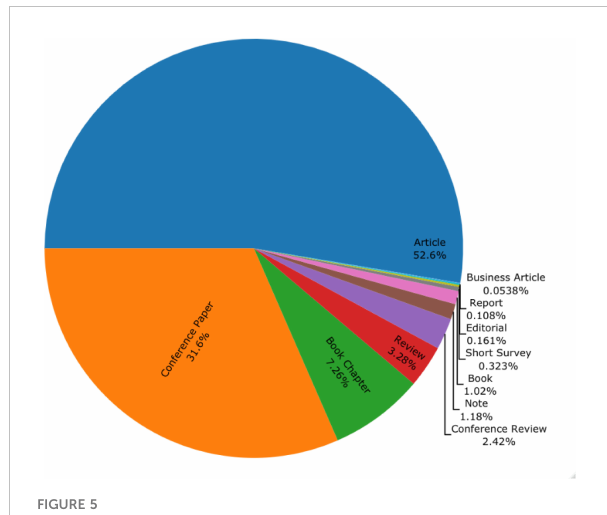
FIGURE 5 Results of scopus database search by publication